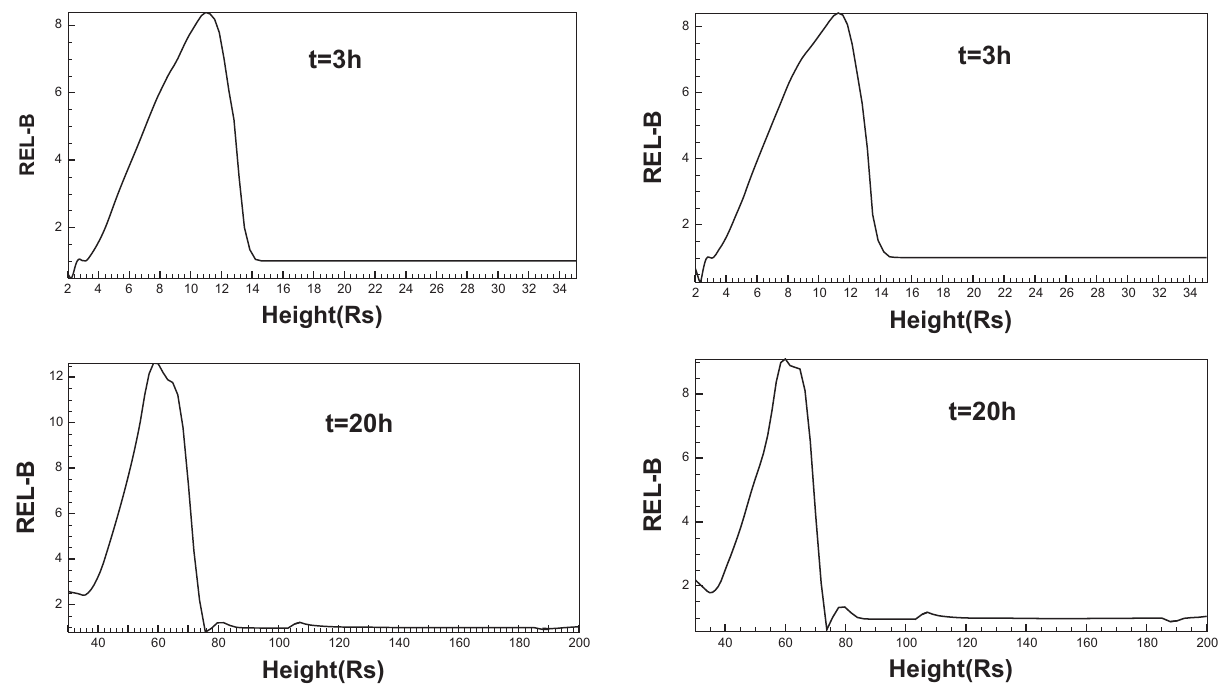
Fig. 9. Evolution of the relative magnetic fi elds B / = 180 (cid:3) (right column) at t = 3 and 20 h, respectively. The top row shows the domain from 1 R R s to 200 R s